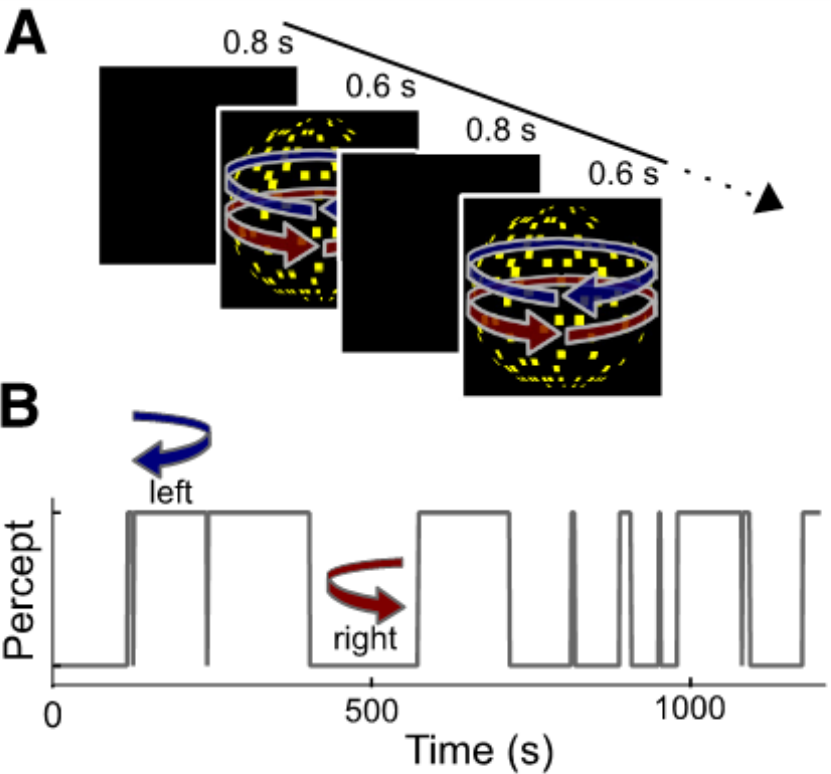
Figure 1. ( A ) A typical trial of the Random Dot Kinematogram (RDK) task. Ambiguous dot kinematogram are presented repeatedly for 600 ms interleaved by a blank screen of 800 ms duration. The sphere can be perceived as rotating either leftward or rightward. Participants are asked to report the perceived direction of the rotation by making a button press. ( B ) The perceptual time course from an example participant. The stabilizing effect of endogenous predictions are automatically built up during intermittent presentation of the ambiguous stimulus, this results in participants tending to have the same percept across successive presentation cycles. The figure is replicated with permission from Schmack et al. [9].